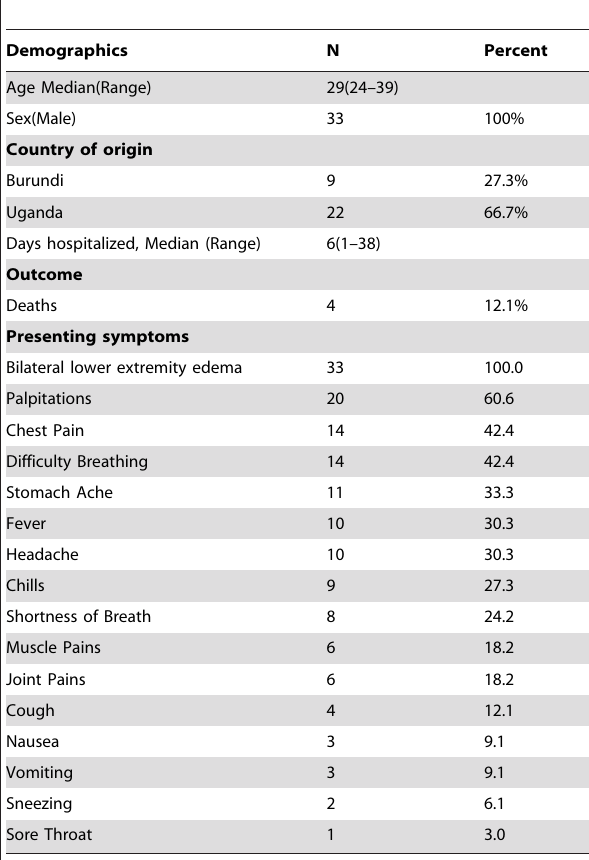
Table 3. Characteristics of beriberi cases admitted to the Aga Khan Hospital, Nairobi, Kenya